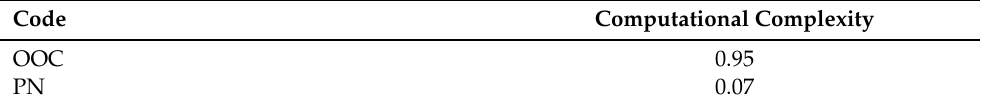
Table 2. Comparison of average simulation computational complexity between the two codes implemented.